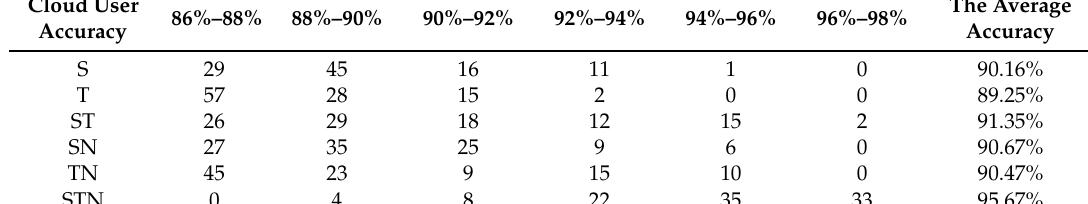
Table 6. Cloud user accuracy for S, T, ST, SN, TN, STN feature fusion on 102 GF-1/2 images. Cloud User